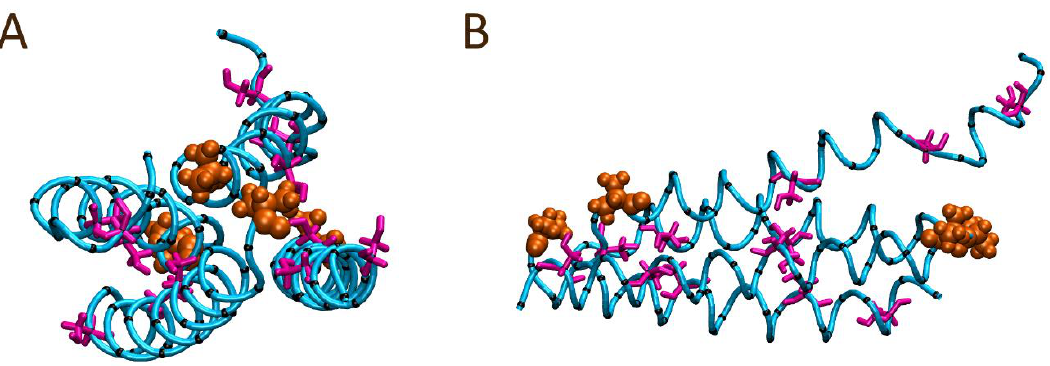
Figure 8. Final peptide alignment of the solution bound four AR28 peptide system modelled with an initial head-to-tail alignment after 100 ns: ( A ) front and ( B ) side views. The N-terminal alanine is shown in orange; the peptide backbone atoms are depicted as the cyan tube; Ser12, Ser20, and Ser26 sidechains are colored magenta; and all other sidechain α-carbons are shown in black with all other sidechain atoms hidden for ease of viewing.